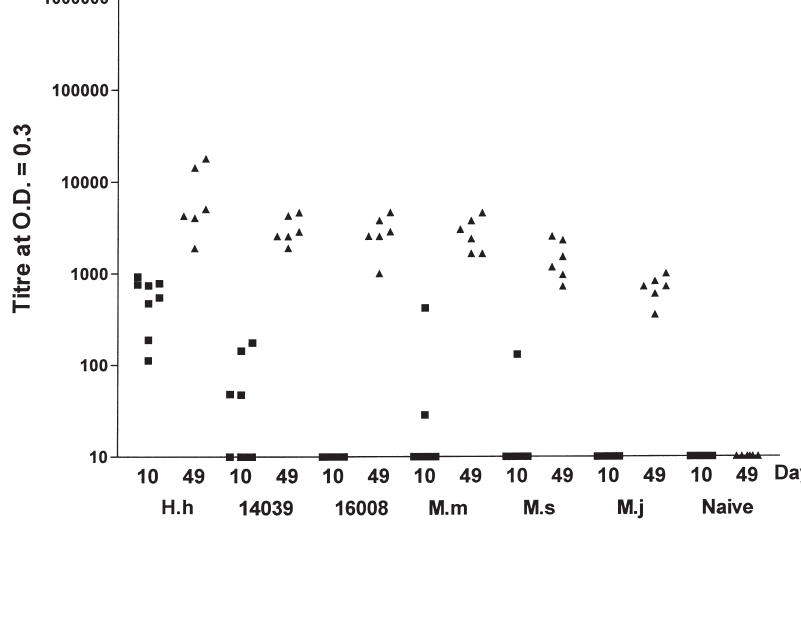
Figure 9. Cytotoxic T-cell re- sponse to OVA entrapped in archaeosomes of various lipid compositions 10 days (A) and 49 days (B) post first injection. C57BL/6 mice were immu- nized subcutaneously on Days 0 and 21 with 15 µg OVA en- trapped in archaeosomes made from archaeal total polar lipids (Table 1). Mice never immu- nized (naive) or immunized with OVA (no adjuvant) were included. Spleens were ob- tained on Days 10 and 49 from duplicate mice in each group and effector cells (E) were pre- pared by stimulating splenic cells for 5 days with irradiated EG.7 cells. Stimulated effector cells were then combined in various ratios with either 51 Cr-labeled EL-4 cells (not expressing OVA peptide, and shown as the respective closed symbol) or 51 Cr-labeled EG.7 targets (expressing OVA pep- tide; open symbols). After 4-h incubations, killing was as- sessed in triplicate cultures by the extent of label released from the targets (T); data are shown as % lysis. Killing of EG.7 targets by splenic cells from OVA (no adjuvant)-im- munized mice was 0.64 and 1.81% for E:T ratios of 3:1 and 100:1,